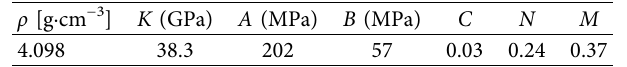
Table 4: Al/Ni reactive material parameters of the J–C constitutive model [13].